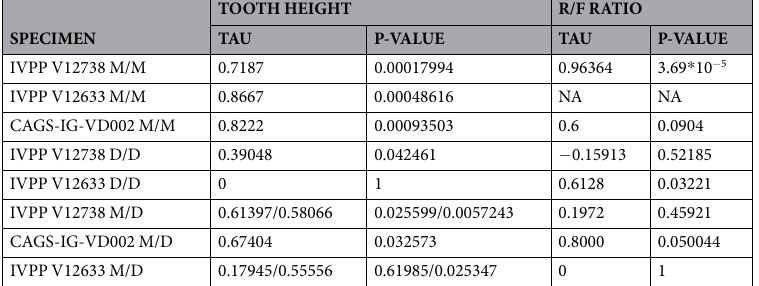
Table 8. Correlation coefficients (Kendall’s Tau) and associated p-values for ranked correlations between jaws in the three studied specimens of Liaoceratops . For CAGS-IG-VD002 and the R/F ratio for IVPP 12633, only the right maxilla and dentary were analyzed for M/D comparisons; other M/D results are listed as